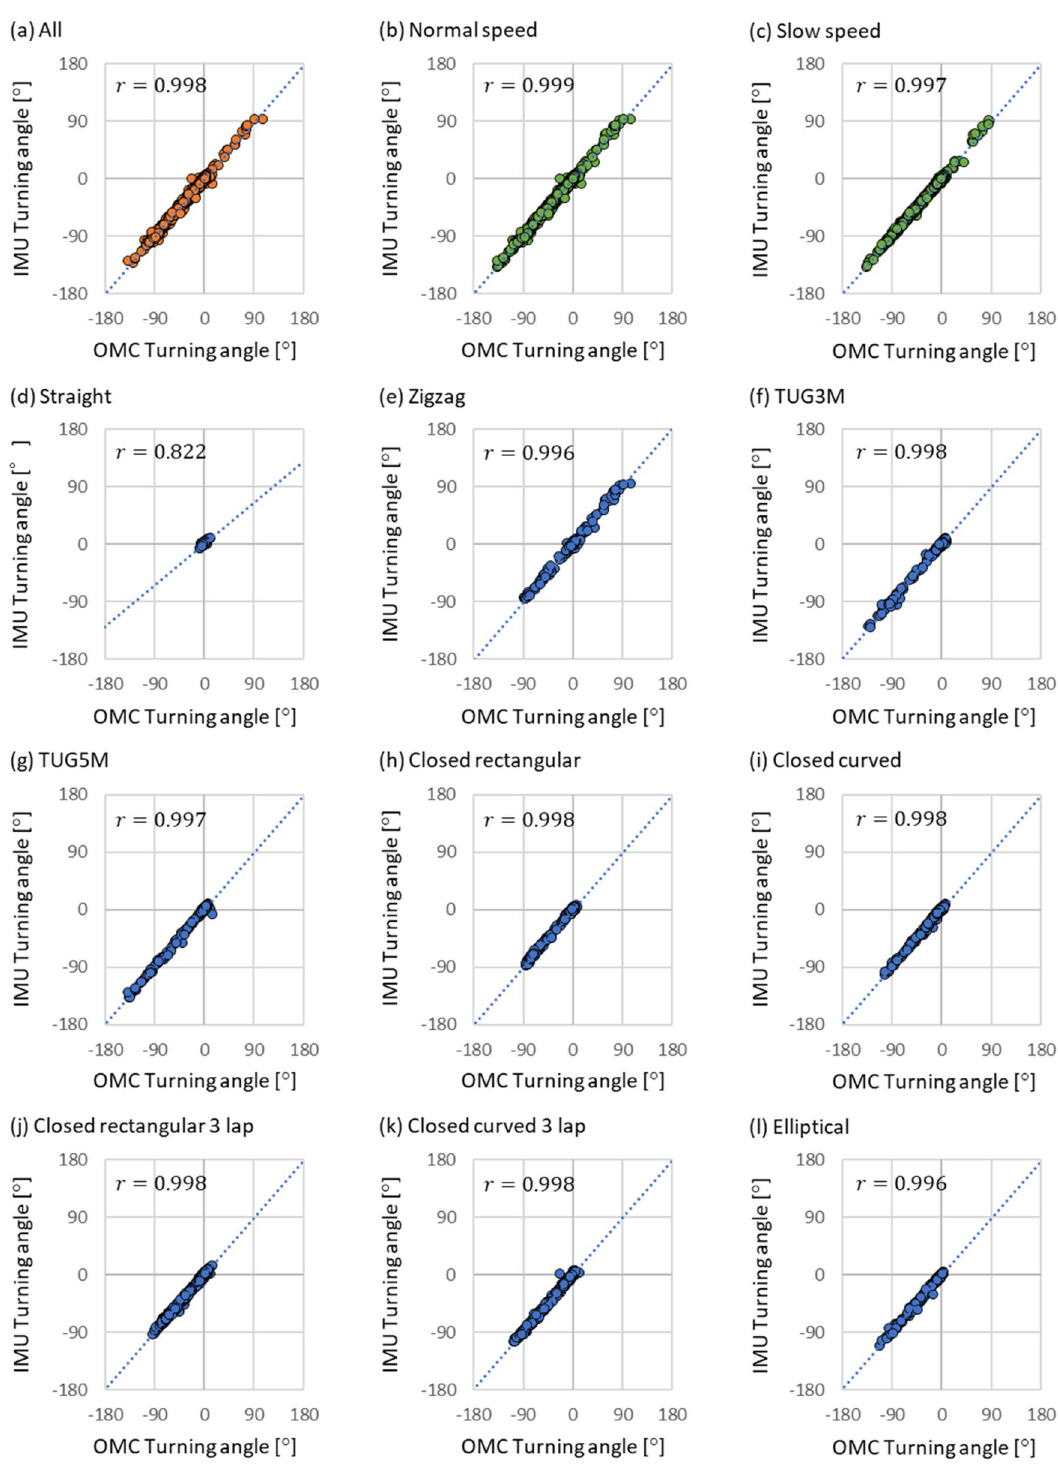
Figure 3. Results of Pearson’s product ratio correlation analysis between the proposed method and the golden standard in turning angle. These results were evaluated for the two walking speed conditions and nine walking route conditions. IMU means the proposed method and OMC means the golden standard as the ground